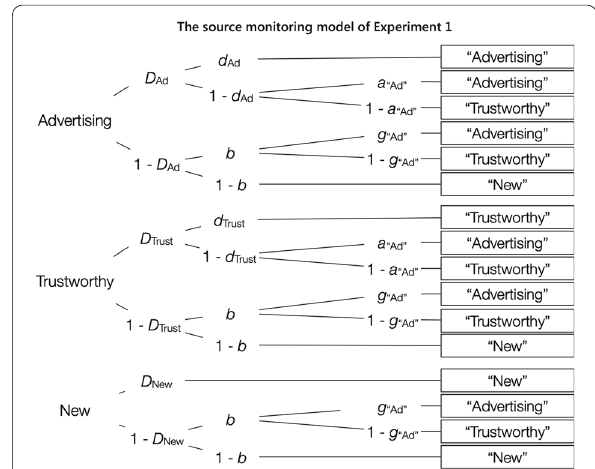
Fig. 2 The source-monitoring model of Experiment 1. Note : The source-monitoring model of Bayen et al. (1996) was adapted to the present Experiment 1. Each model tree represents the cognitive processes in response to the advertising, trustworthy, and new statements that were presented in the source-monitoring test. The rectangles on the right represent the participants’ responses. Letters along the branches represent the latent cognitive processes which lead to these responses with certain probabilities ( D ∙ statement = recognition, d ∙ source memory, b guessing that the statement = = had been presented in the exposure phase, a “Ad” guessing = that a recognized statement was from the advertising source, g “Ad” guessing that an unrecognized statement was from the = advertising